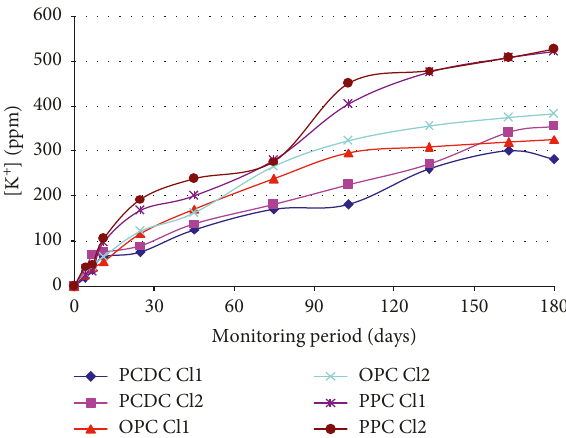
Figure 5: K + analyses in chloride-simulated solution.